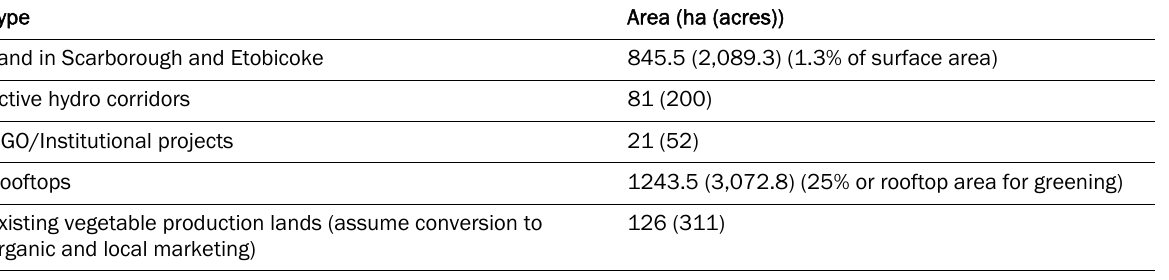
Table 5. Summary of Growing Area Requirements, Scarborough and Etobicoke